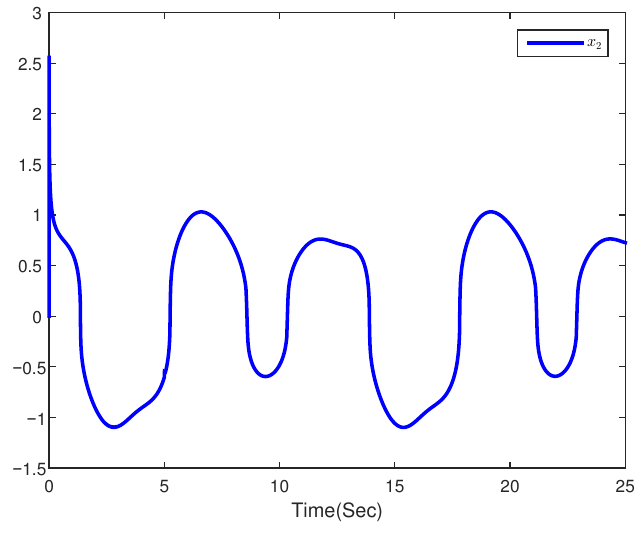
Figure 5. The system state x 2 (Case 1).